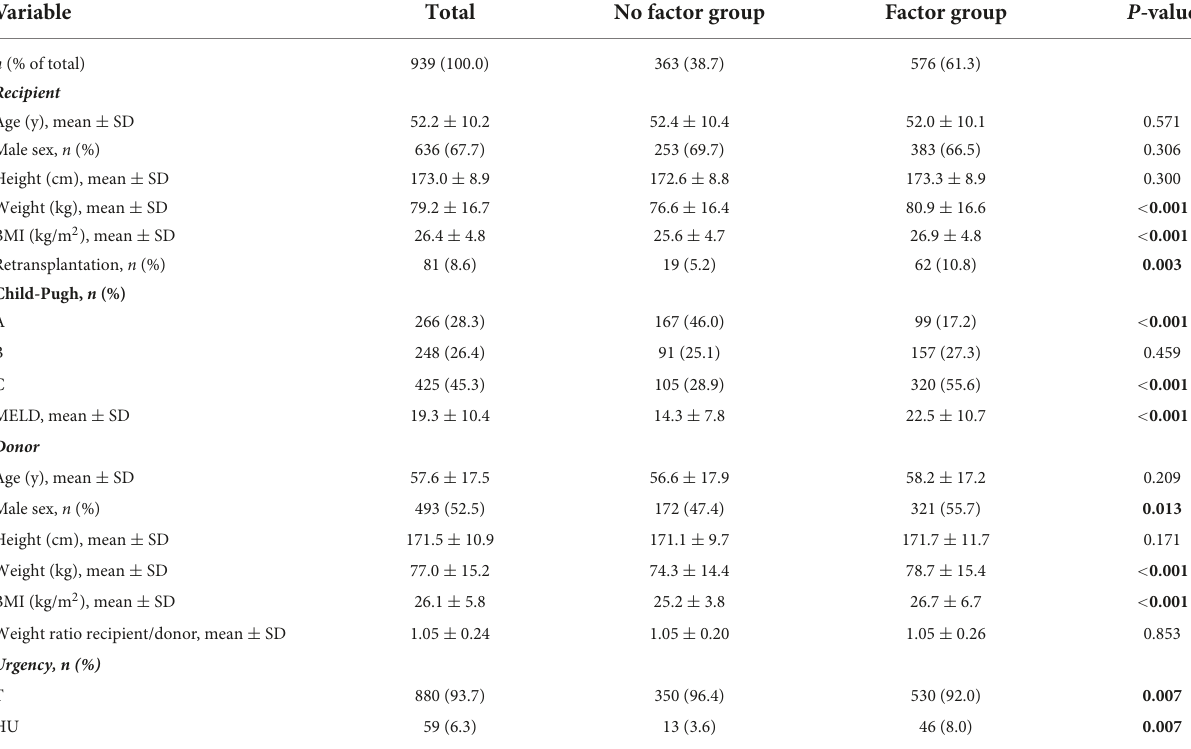
TABLE 1 Clinical baseline characteristics of the study cohort. Variable Total No factor group Factor